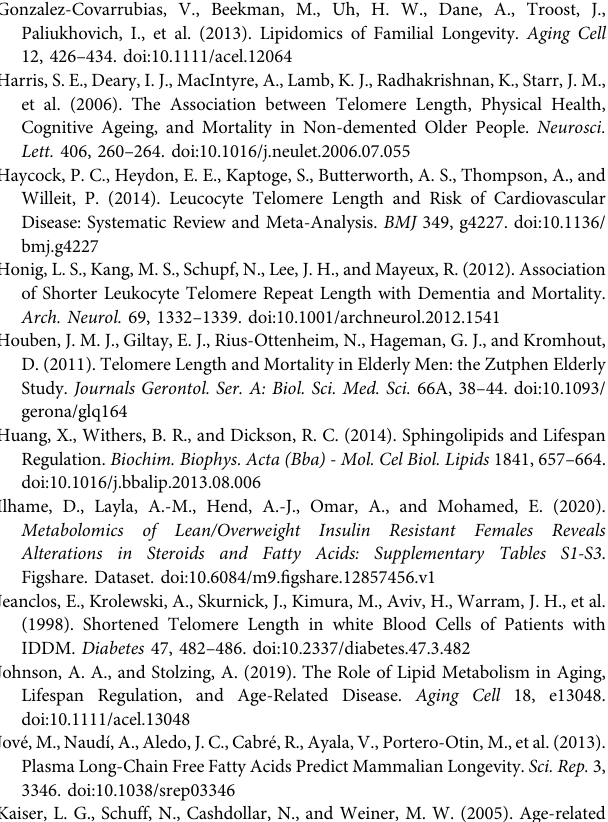
Figshare. Dataset. doi:10.6084/m9. fi gshare.12857456.v1 Jeanclos, E., Krolewski, A., Skurnick, J., Kimura, M., Aviv, H., Warram, J. H., et